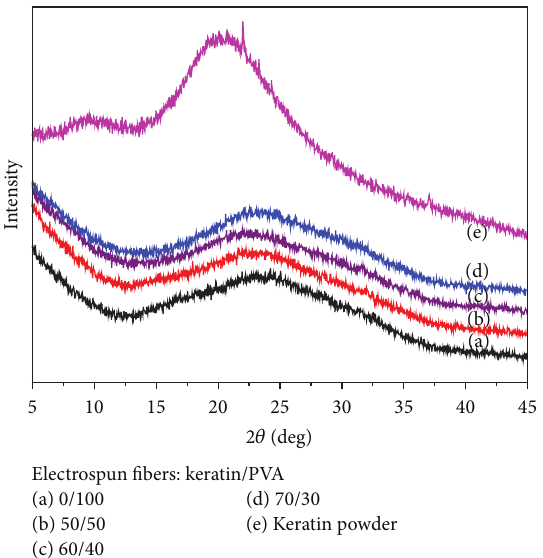
Figure 6: XRD patterns of (a) electrospun PVA and (e) keratin powderaswellastheblendnanofibersobtainedusingvariousweight ratios of keratin to PVA: (b) 50/50, (c) 60/40, and (d) 70/30.